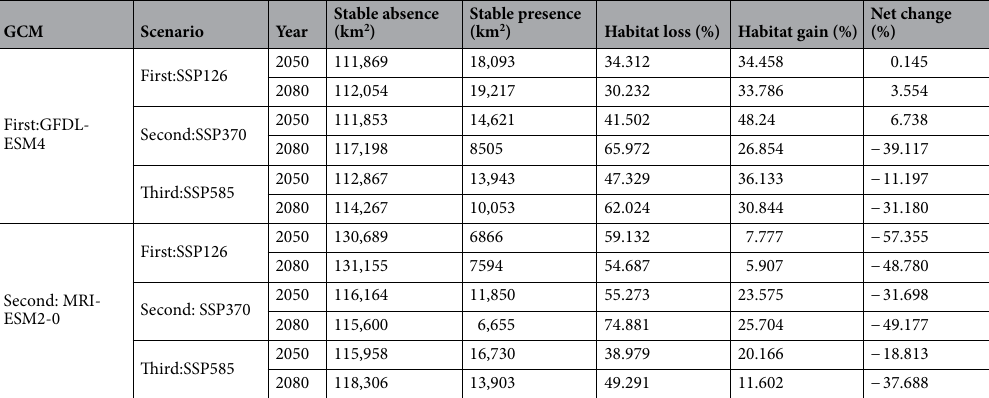
Table 3. Changes in the suitable habitat area for S. inflata under climate change conditions in Isfahan province compared to the current distribution in percent and absolute area